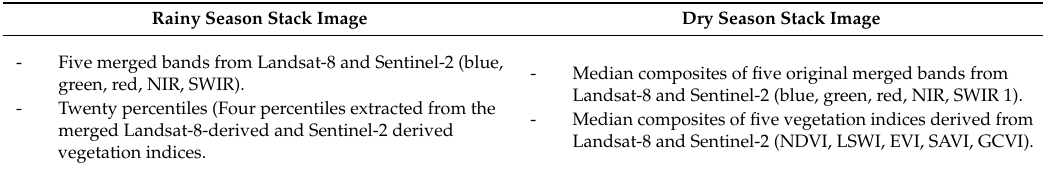
Table 3. The two seasonal stack images that composed the yearly